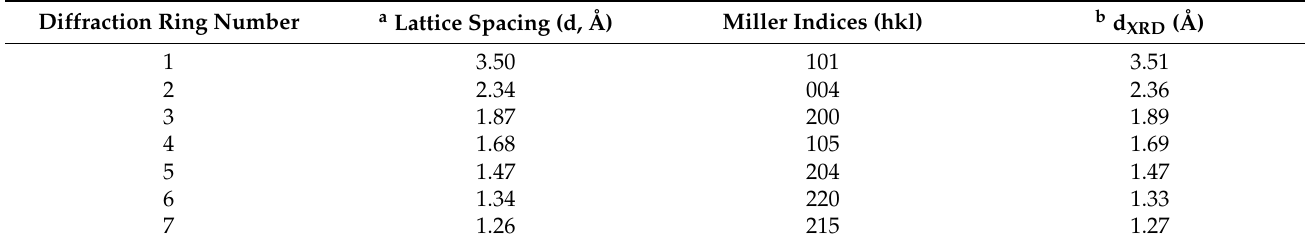
Figure 4. ( a – c ) TEM images showing morphology and crystallinity of TS82C composite calcined at 550 ◦ C, ( a ) low magnification, ( b , c ) high resolution (HRTEM) images, and ( d ) selected area electron diffraction (SAED) pattern taken from image ( c ). The lattice spacing of the respective rings numbered in the SAED pattern is summarized in Table 2. Table 2. Lattice parameters of the nanocrystalline TS82C calculated from SAED (Figure 4d) and XRD pattern (Figure